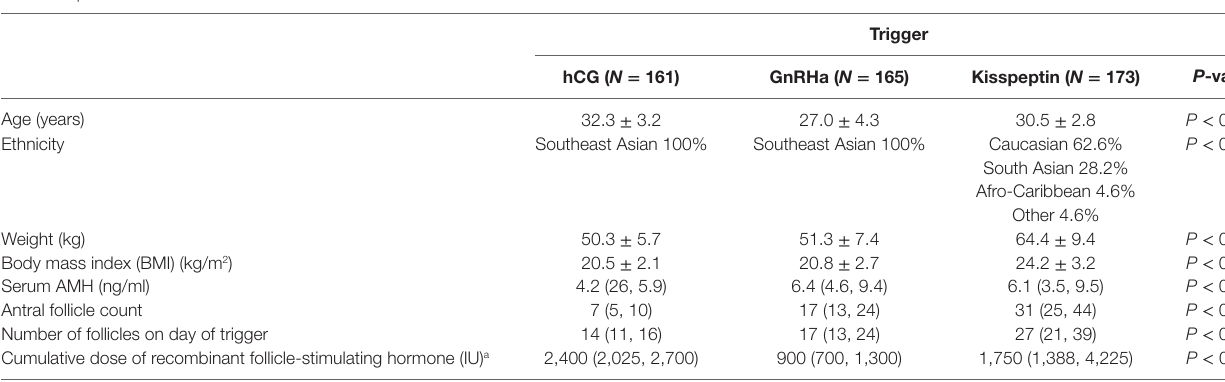
Table 1 | Baseline